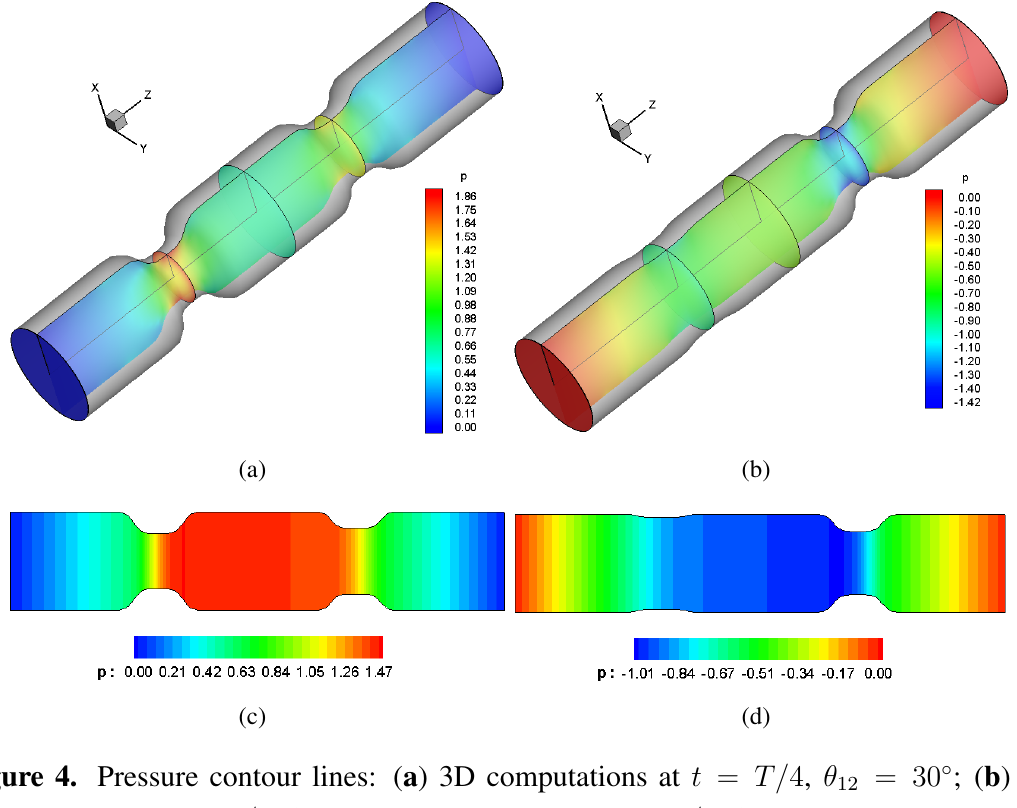
Figure 4. Pressure contour lines: ( a ) 3D computations at t = T/ 4 , θ = 30 ◦ ; ( c ) 2D theory at t = T/ 4 , θ computations at t = 3 T/ 4 , θ 12 t = 3 T/ 4 , θ = 30 ◦ 12